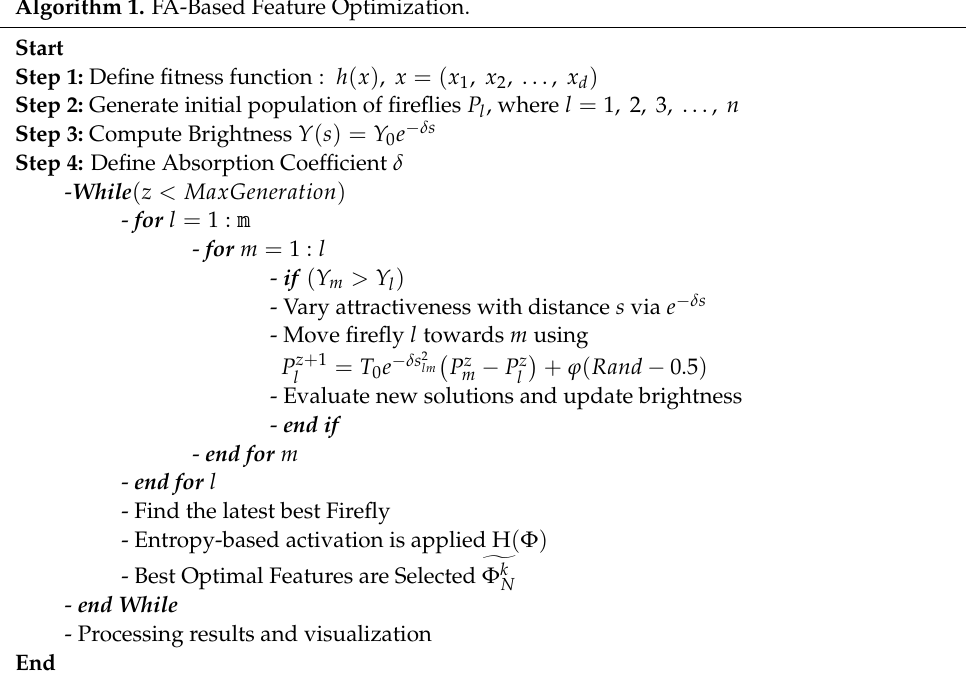
Algorithm 1. FA-Based Feature Optimization.